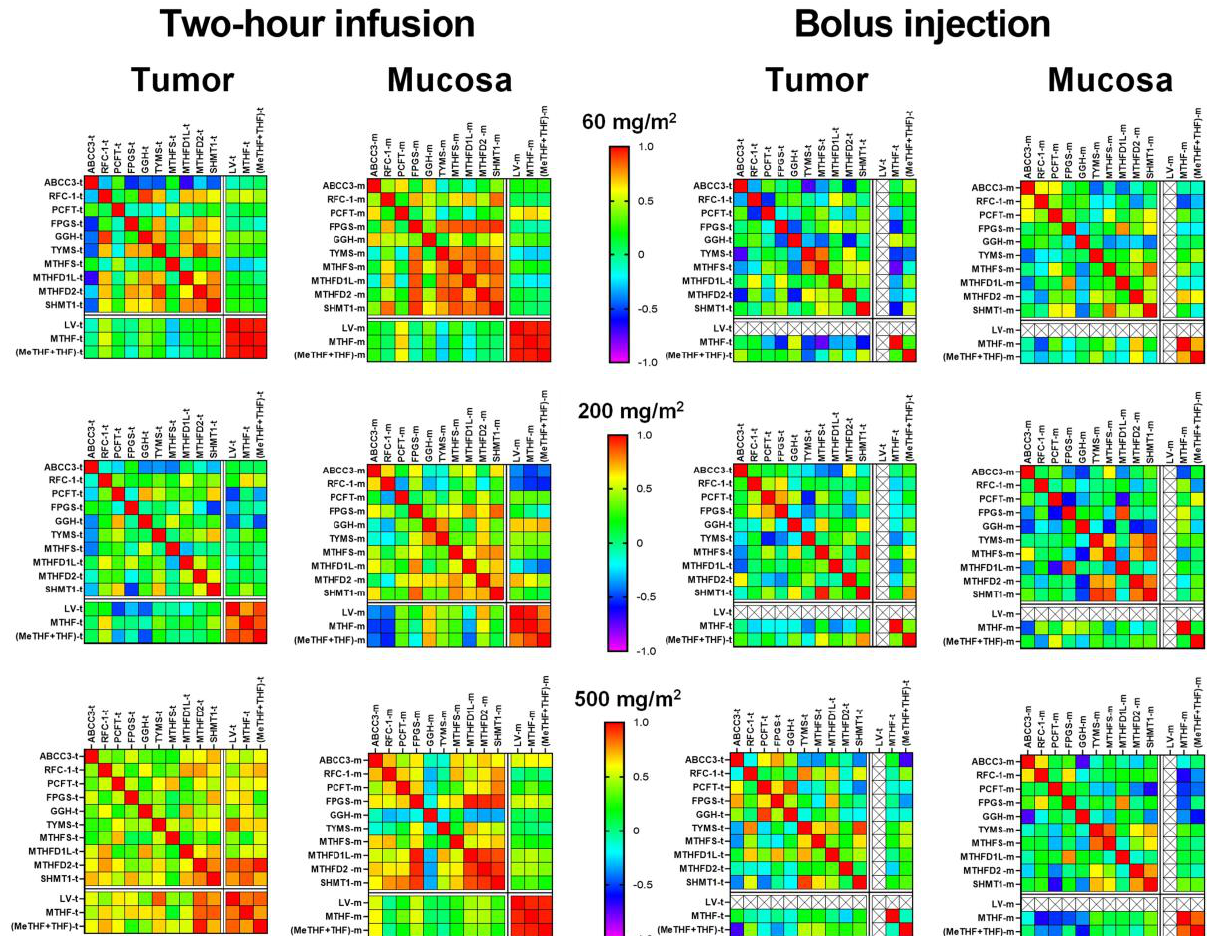
Figure 6. Heat maps showing the correlation between gene expression and folate levels in tumor and mucosa tissues after administration of different dosages of LV given either as two-hour infusion ( left panels ) or bolus injection ( right panels ). The strongest positive correlation (1.0) is shown in red whereas the strongest negative correlation ( − 1.0) is shown in purple. LV in tissue was not analyzed in the bolus group.